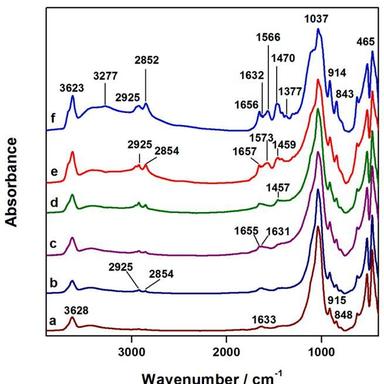
MIR spectra of PEI-Mt prepared with a) 21, b) 30, c) 43, d) 86, e) 172, and f) 301 mg of PEI per 1 g of Mt.